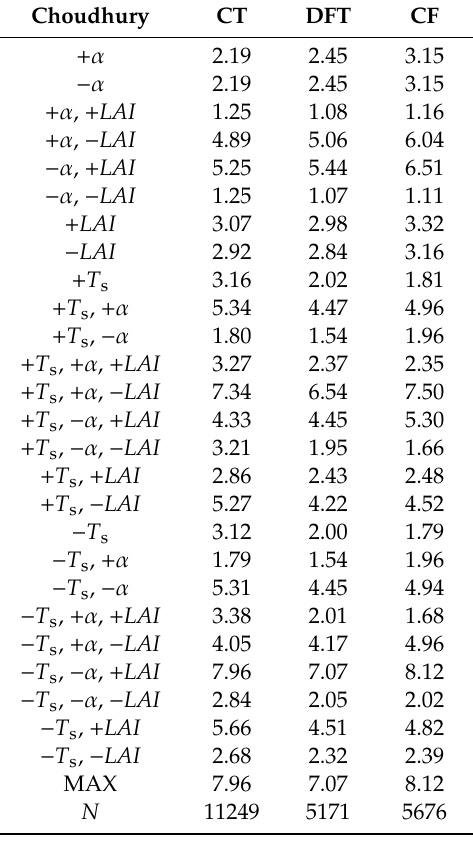
Table 4. VR accuracy , the ultimate sensitivity coe ffi cient, of the scheme Choudhury. Choudhury